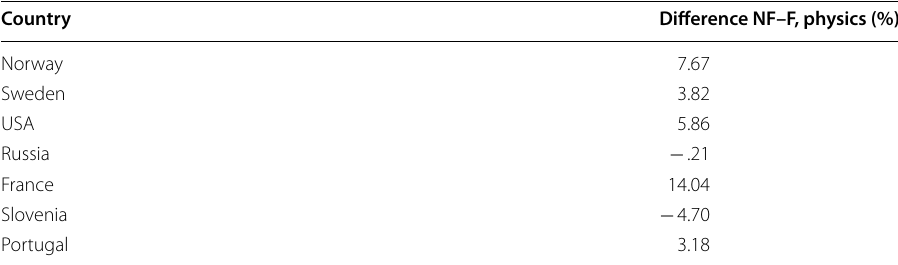
Table 7 Differences between average p -values for NF items and F items in TIMSS